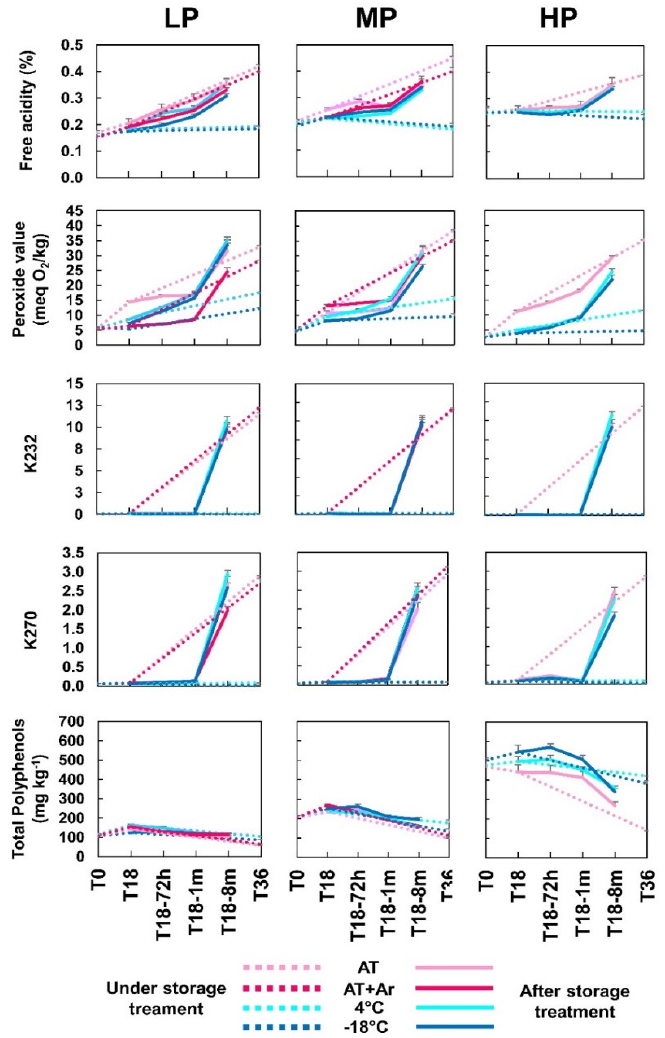
Figure 1. Free acidity (percentage of oleic acid), peroxide value (meq O 2 /kg), K 232 and K 270 extinction coefficients, and total polyphenols (mg kg -1 of oil) of low, medium, and high phenolic (LP, MP, and HP, respectively) EVOOs under different storage conditions and time points. Dot lines: T0, T18, and T36 (under storage treatment); solid lines: T18-72 h, T18-1 m, and T18-8 m (after storage treatment). Bars represent means ± SD of three replicates.